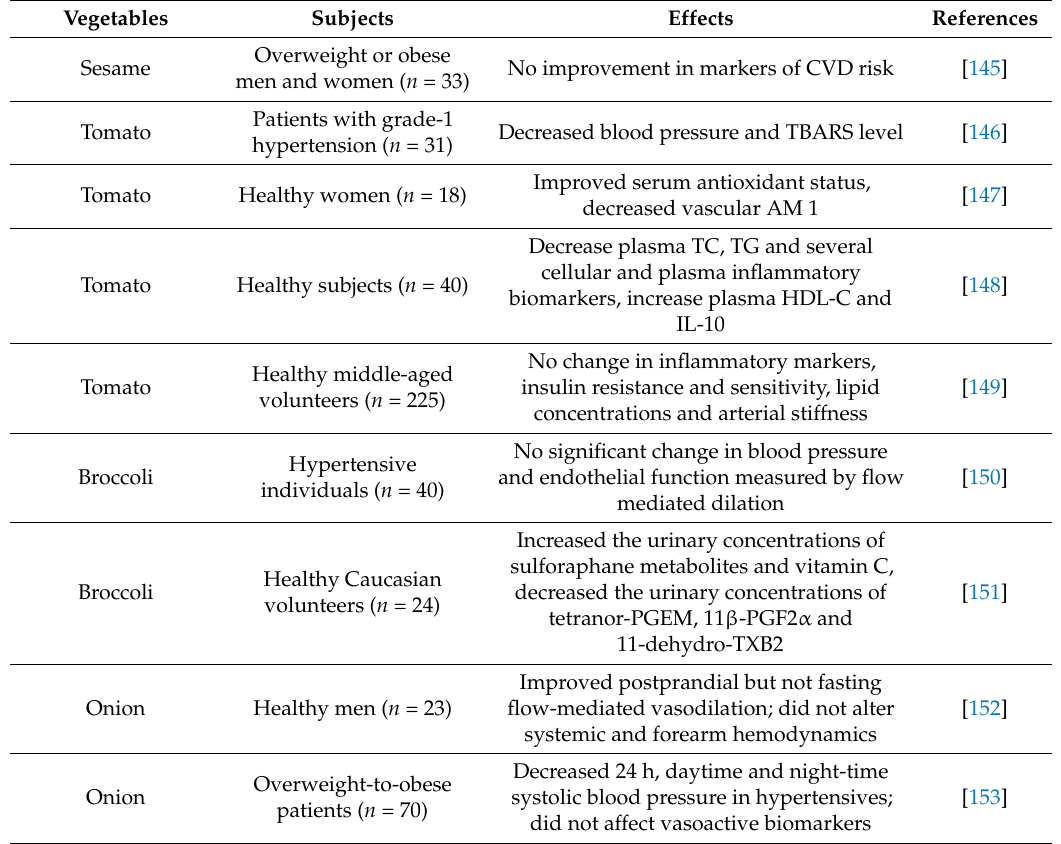
Table 4. Relationship between other vegetables and